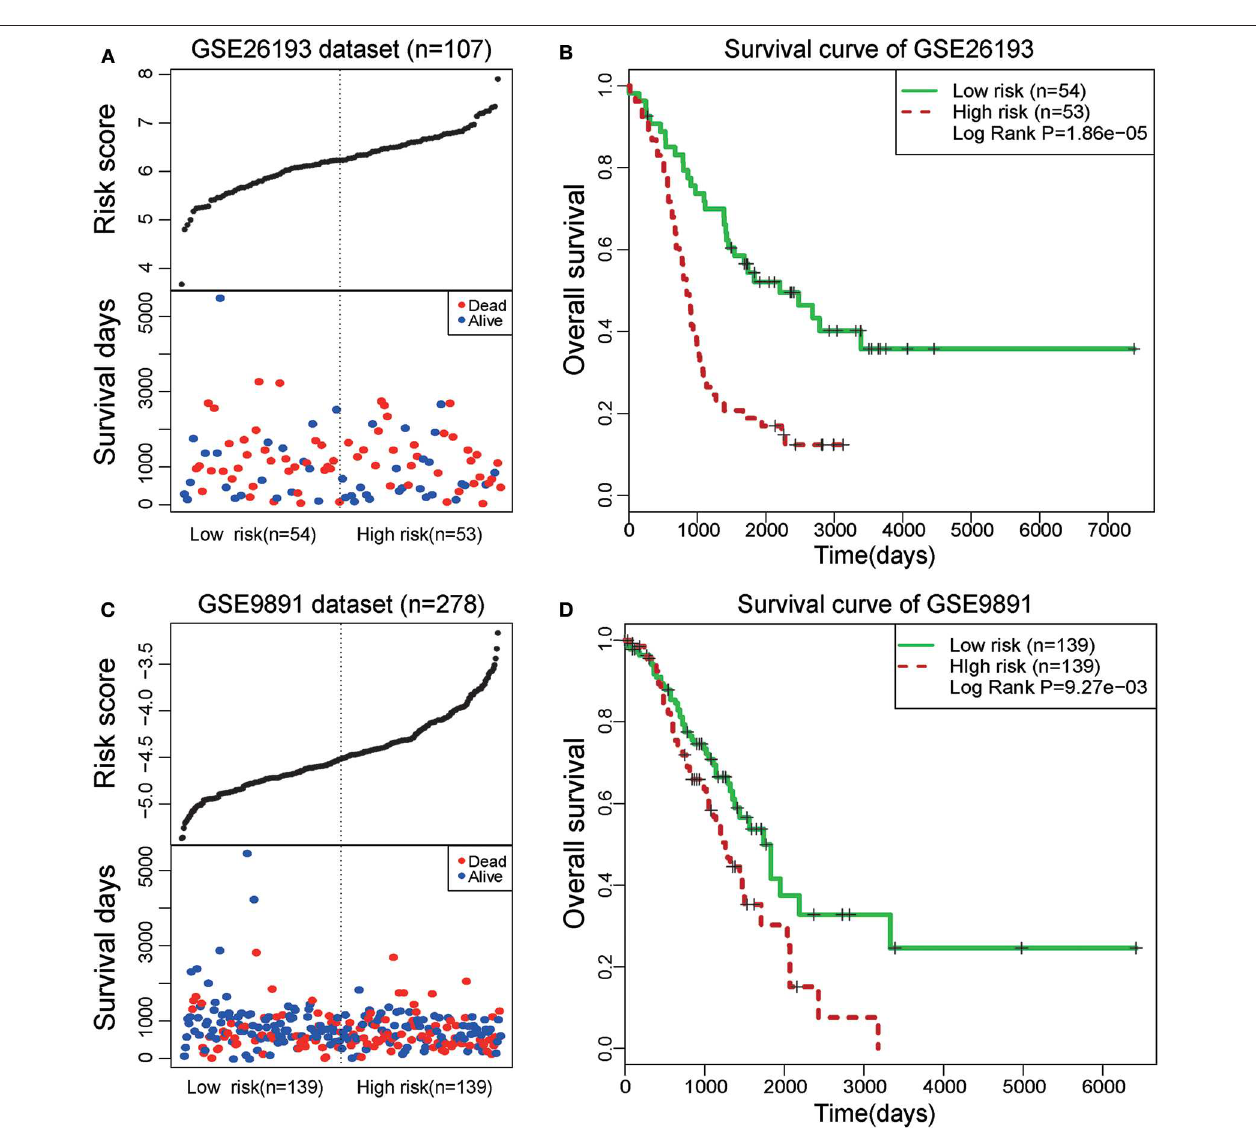
FIGURE 7 | Survival analysis of STAT3-FOS-regulating TF-lncRNA clique in another two-independent dataset. (A) The risk scores and survival status of this clique in the GSE26193 dataset. (B) Kaplan-Meier survival curves revealed significant difference in survival between the two groups of patients in the GSE26193 dataset. (C) The risk scores and survival status of this clique in the GSE9891 dataset. (D) Kaplan-Meier survival curves revealed significant difference in survival between the two groups of patients in the GSE9891 dataset.